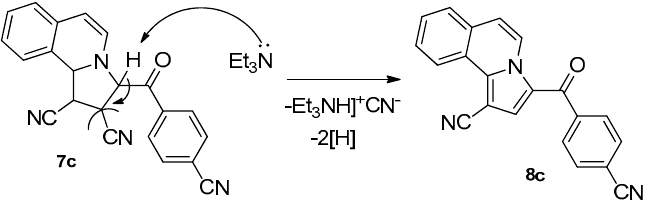
Scheme 5. Proposed reaction mechanism for the formation of fused isoquinoline derivative 8c.